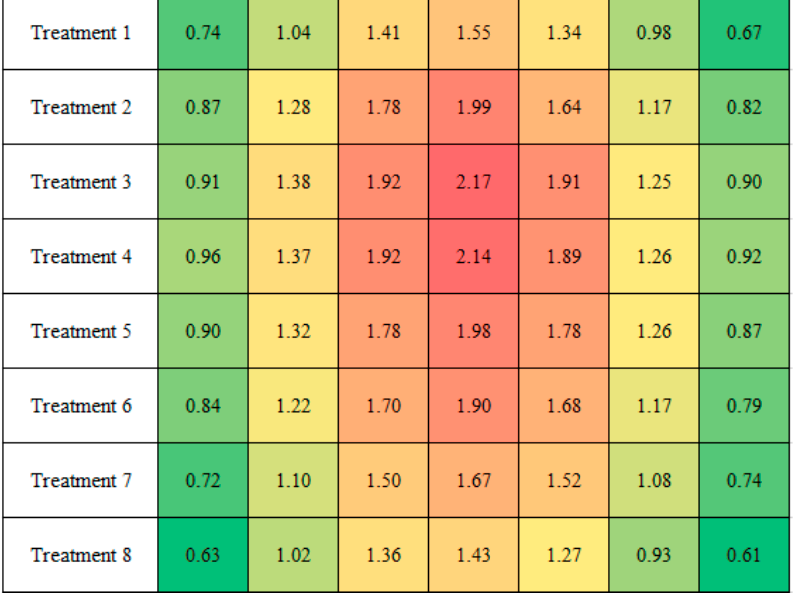
Figure A6. Map of UV light intensity (irradiance) measurements for UV ‐ C (222 nm) for Treatment 1 to Treatment 8. The color gradient green–yellow–red represents increasing UV light intensity. Units: mW/cm 2 .